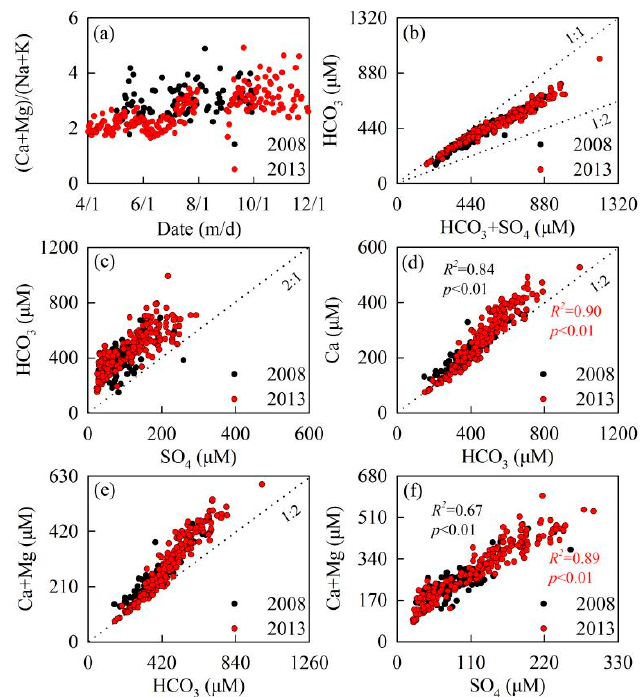
Figure 9. Variations in molar (Ca + Mg)/Na + K) ratios ( a ), as well as in HCO 3 versus HCO 3 + SO 4 ( b ), HCO 3 versus SO 4 ( c ), Ca versus HCO 3 ( d ), Ca + Mg versus HCO 3 ( e ) and Ca + Mg versus SO 4 ( f ) for